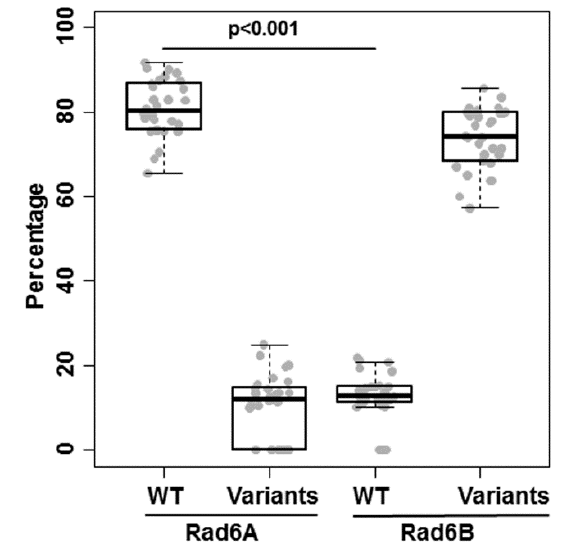
Figure 5. Whole exome sequence analysis of RAD6A and RAD6B transcripts in primary and metastatic cutaneous melanoma xenografts. The percentages of wild-type (WT) and variant forms of RAD6A and RAD6B transcripts identified in 30 melanoma patients are shown. Comparisons of the percentages of WT RAD6A and WT RAD6B were made using the Wilcoxon test for paired samples. The box plots represent the minimum, Q1, median, Q2, and maximum of percentages. The details of RAD6A and RAD6B variants, patient demographics and stage of disease are provided in Supplementary Tables 1 and 2.